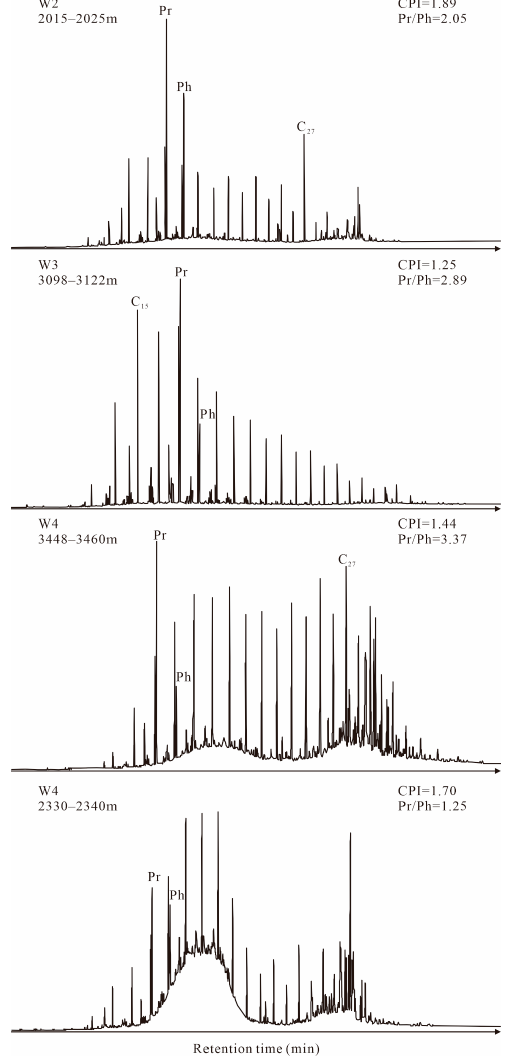
Figure 4. Gas chromatograms of the extractable saturated fractions showing the distribution of n -alkanes for source rock samples from LS2 of the Weixinan Sag, Beibuwan Basin. The CPI (carbon preference index) values of the studied source rock samples range from 1.11 to 2.69, with a mean of 1.49, which indicate that the n -alkanes exhibit an